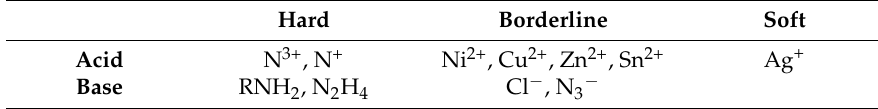
Table 5. Classification of ions present in the solution on the basis of hard soft acid base (HSAB) theory. Hard